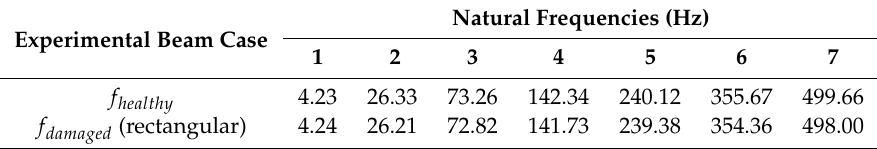
Table 6. Experimentally identified natural frequencies of healthy and rectangular damaged